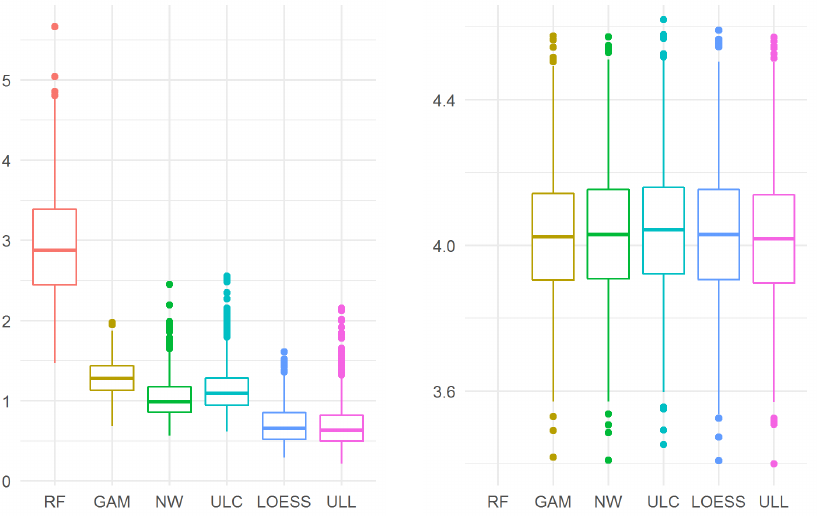
Figure 2. The maximum ( left ) and mean squared ( right ) errors in Example 2. For the mean squared error, the random forest model performed worse (10.97 (10.55, 11.39)) than the GAM model and the